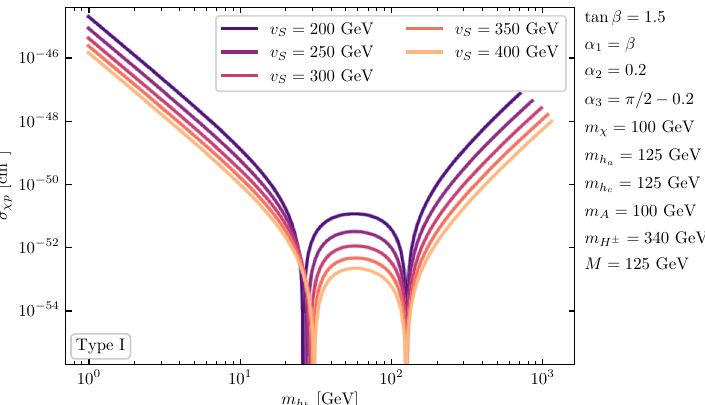
Figure 7 . DM-proton scattering cross section σ χp in dependence of the mass of one of the CP-even Higgs bosons m h for different values of the singlet vev v S in type I. The other parameters are fixed b to the values shown on the